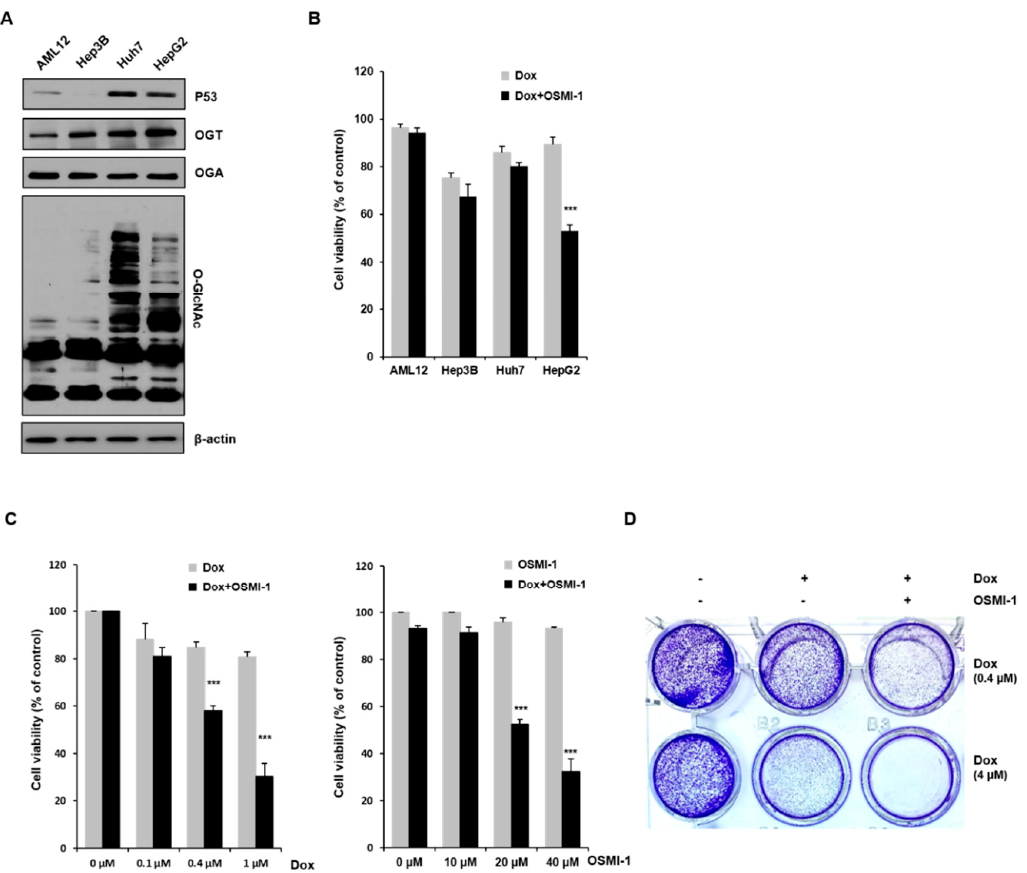
Figure 1. Effects of OSMI-1 and doxorubicin (DOX) on the cell viability of hepatocellular carcinoma (HCC) cells. ( A ) Immortalized human liver cells (AML12) and human hepatocellular carcinoma (HCC) cells (Hep3B, Huh7, and HepG2) were analyzed by Western blot for p53, O-GlcNAc transferase (OGT), O-GlcNAcase (OGA), and O-GlcNAc. β -actin served as a loading control. The graphs on the right show the relative amount of measured protein as fold increase, the uncropped western blot figures in Figure S3. ( B ) AML12, Hep3B, Huh7, and HepG2 cells were treated with 0.4 μ M of DOX